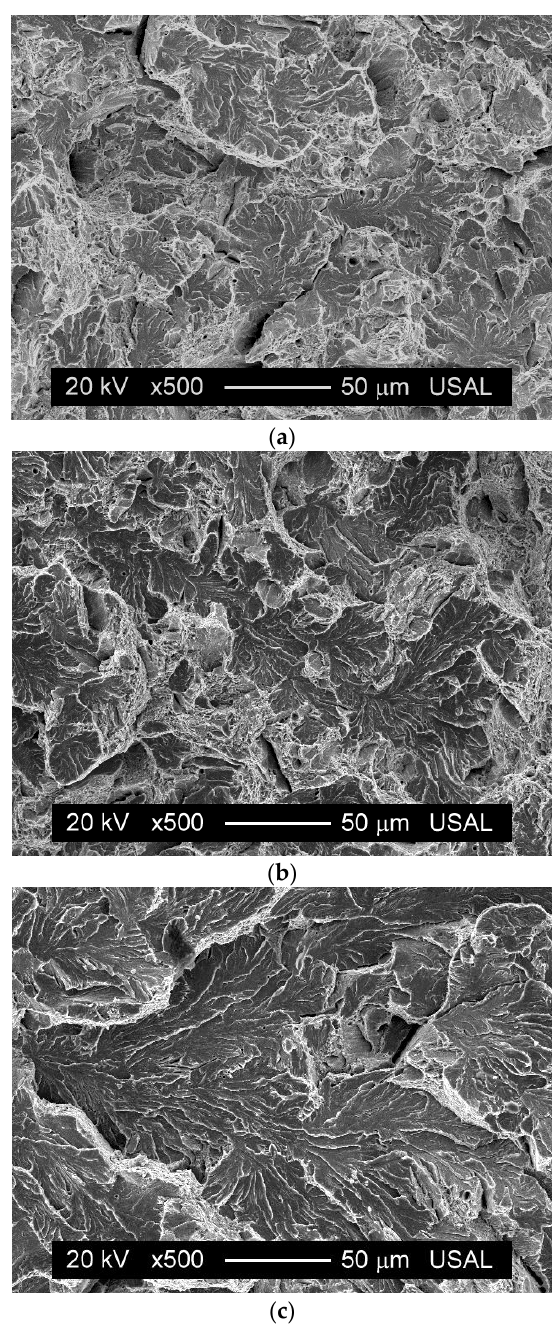
Figure 8. Unstable propagation zone (UPZ) in the steels cooled using: ( a ) AC; ( b ) POF; ( c ) FCF. According to previous research [5,24], the critical fracture unit in pearlitic microstructures is a region where the crystalline structure of ferrite (and cementite) of neighboring colonies shares a common orientation. The size of this orientation unit is controlled by the PAG size and, therefore, can